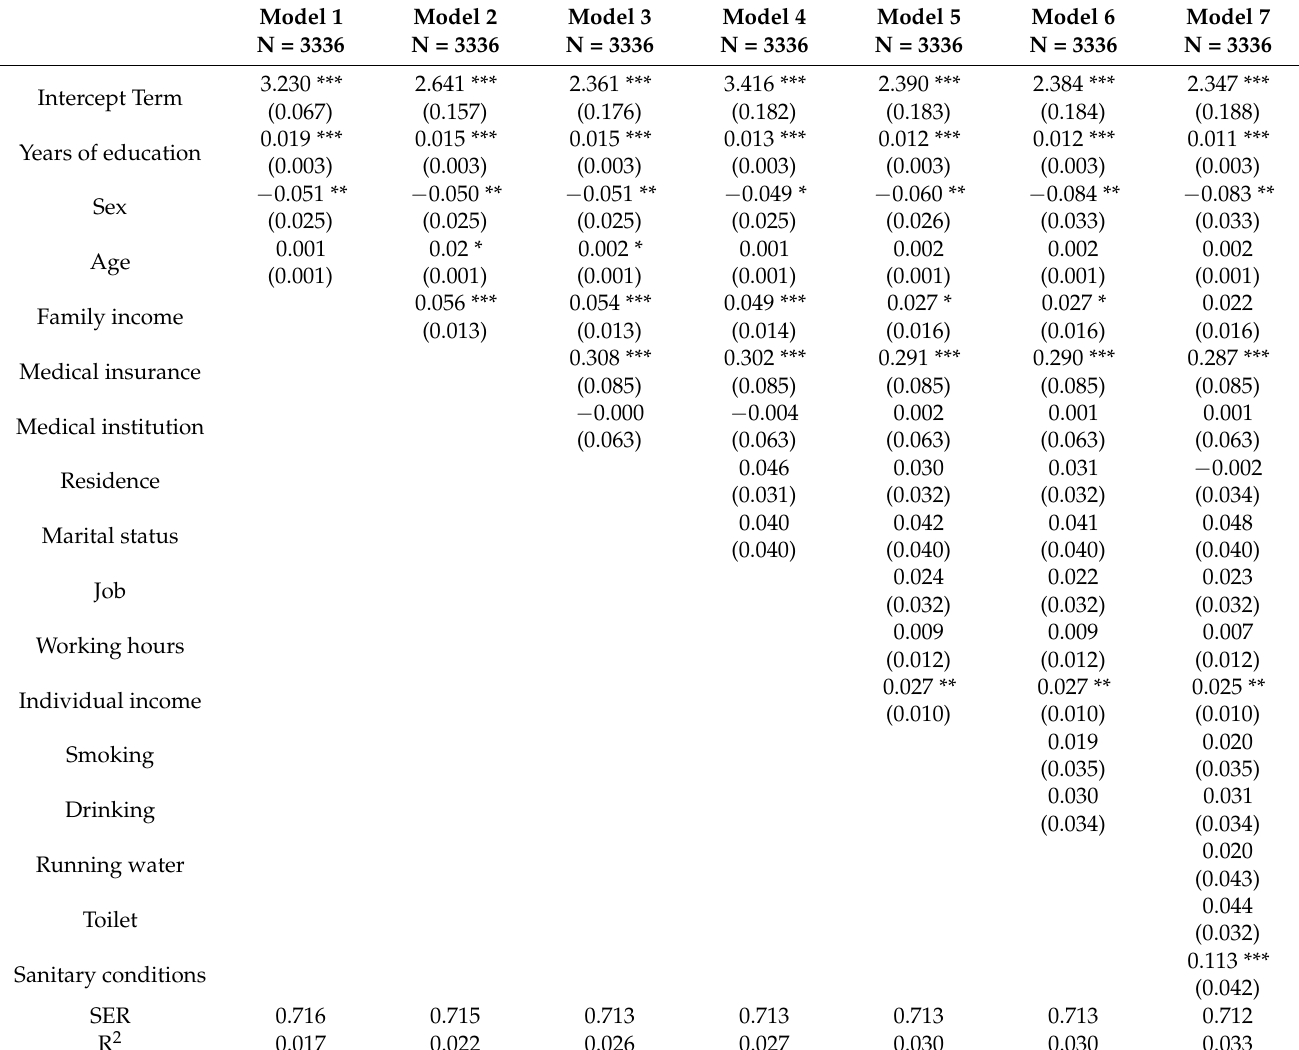
Table 3. Results of the impact of education, medical services, and living conditions on psychological